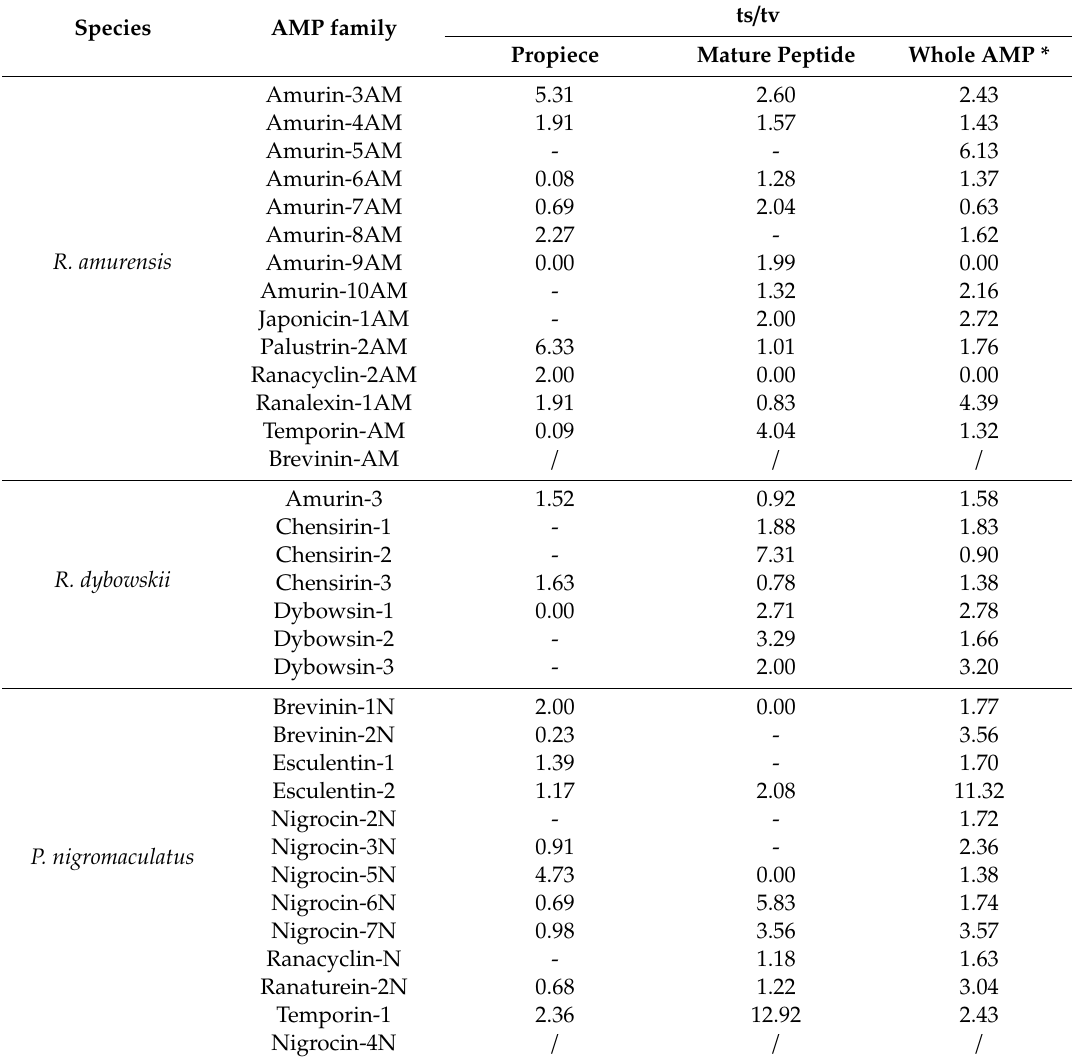
Table 2. The t s / t v ratios of propiece and mature peptide of antimicrobial peptides (AMPs)AMPs in three anuran